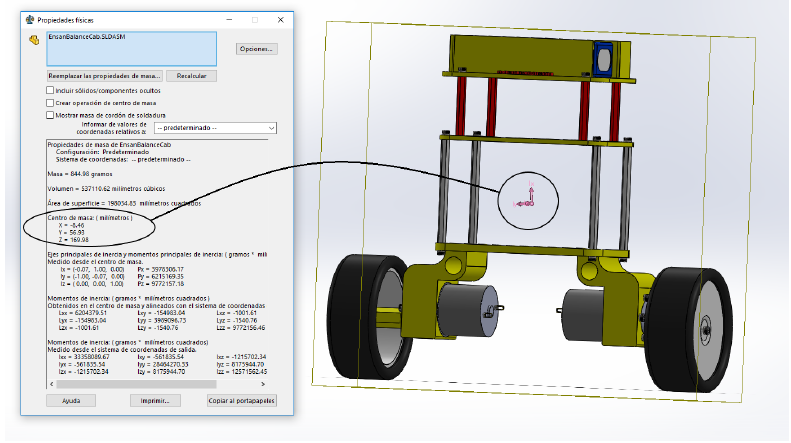
Figure 18. Final system of center of mass.